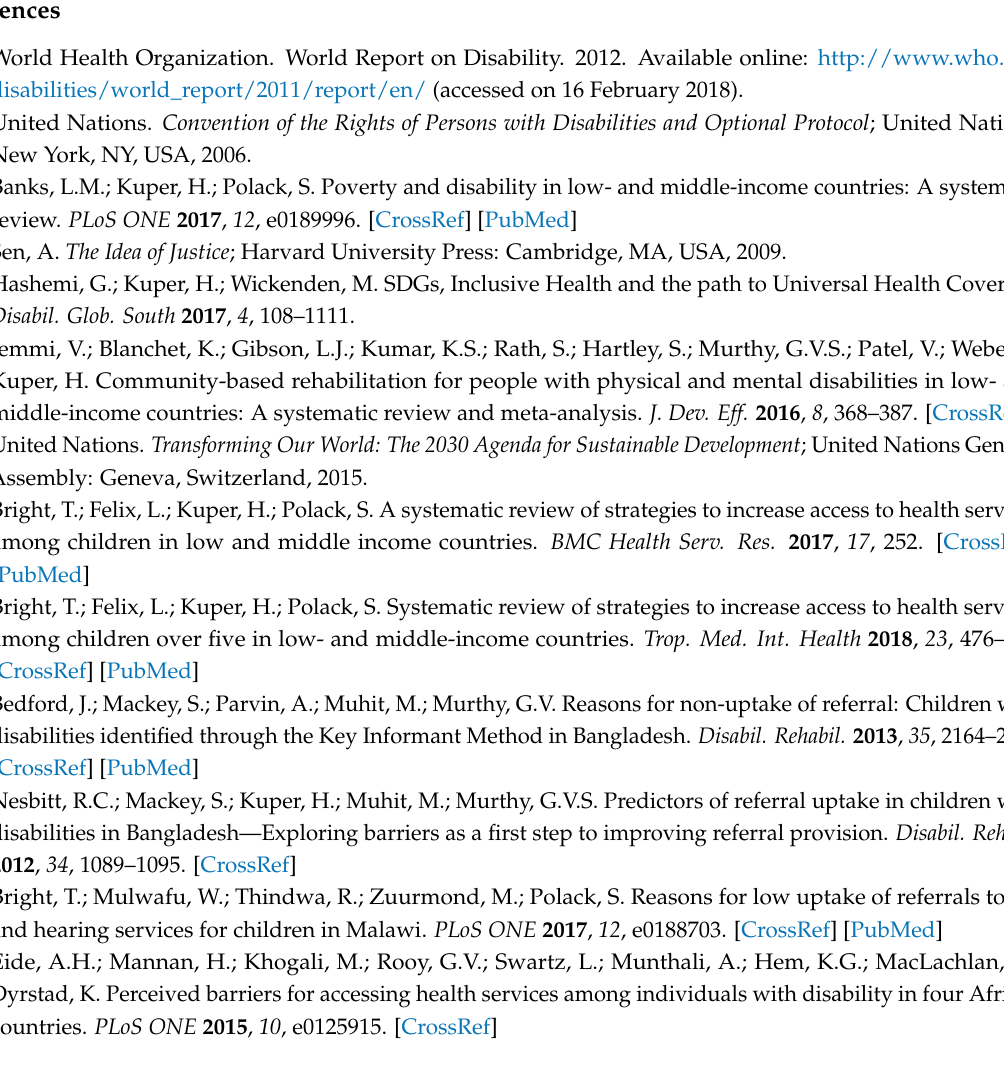
s1, Table S1: Rationale for each component of the intervention in Malawi, Table S2: Example: Insight development for the ‘comfort and confidence’ theme, Figure S1: Theory of change for improving uptake of referral for ear and hearing services in Malawi, Figure S2: Theory of Change for the menstrual hygiene behaviour change intervention in